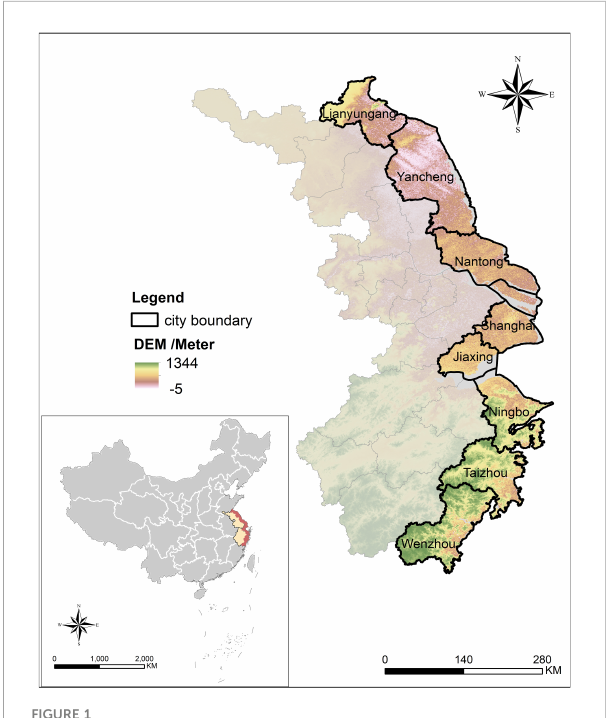
FIGURE 1 Geographical location of study